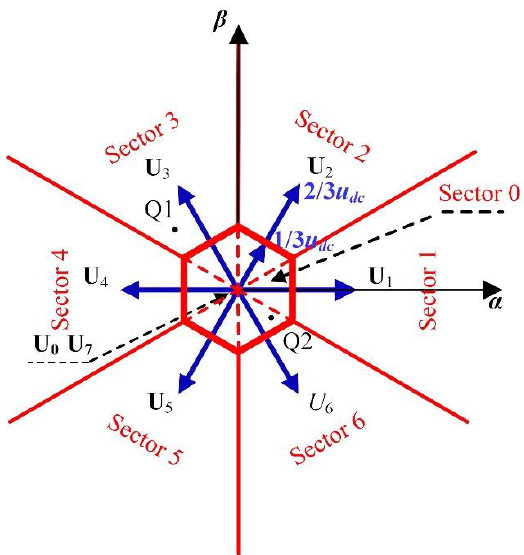
Figure 2. Distribution of reference voltage vector with accurate measurement.